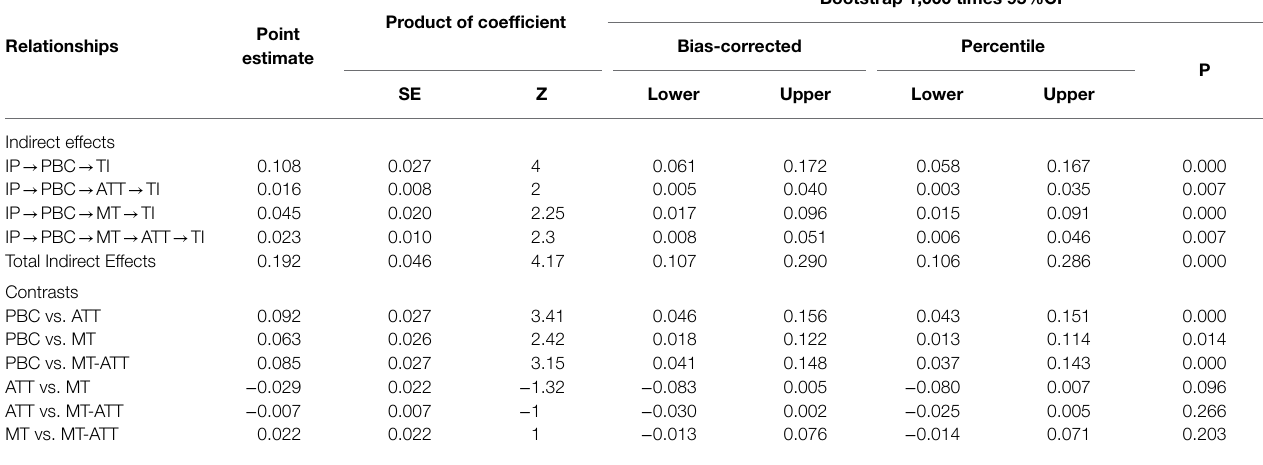
TABLE 7 | Intermediary effect test table.